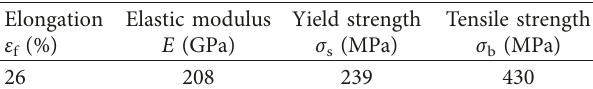
Table 2: Mechanical properties.